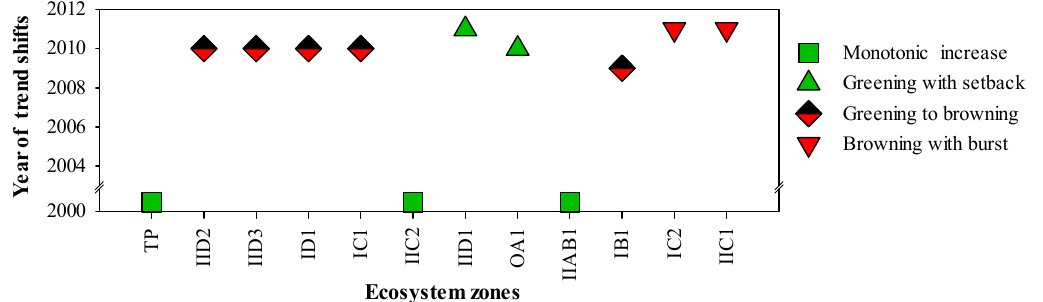
Figure 4. Timing of major trend shifts in vegetation greenness across the entire Tibetan Plateau (TP) and different ecosystem zones based on the BFAST model.